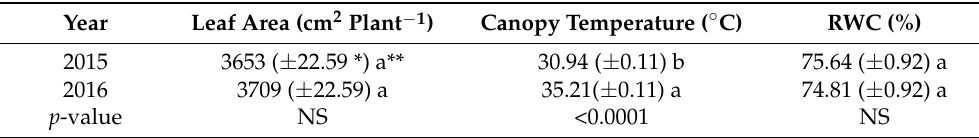
Table 4. Effect of year on leaf area, canopy temperature and leaf relative water content (RWC) of maize at 90 DAS in Dharwad,